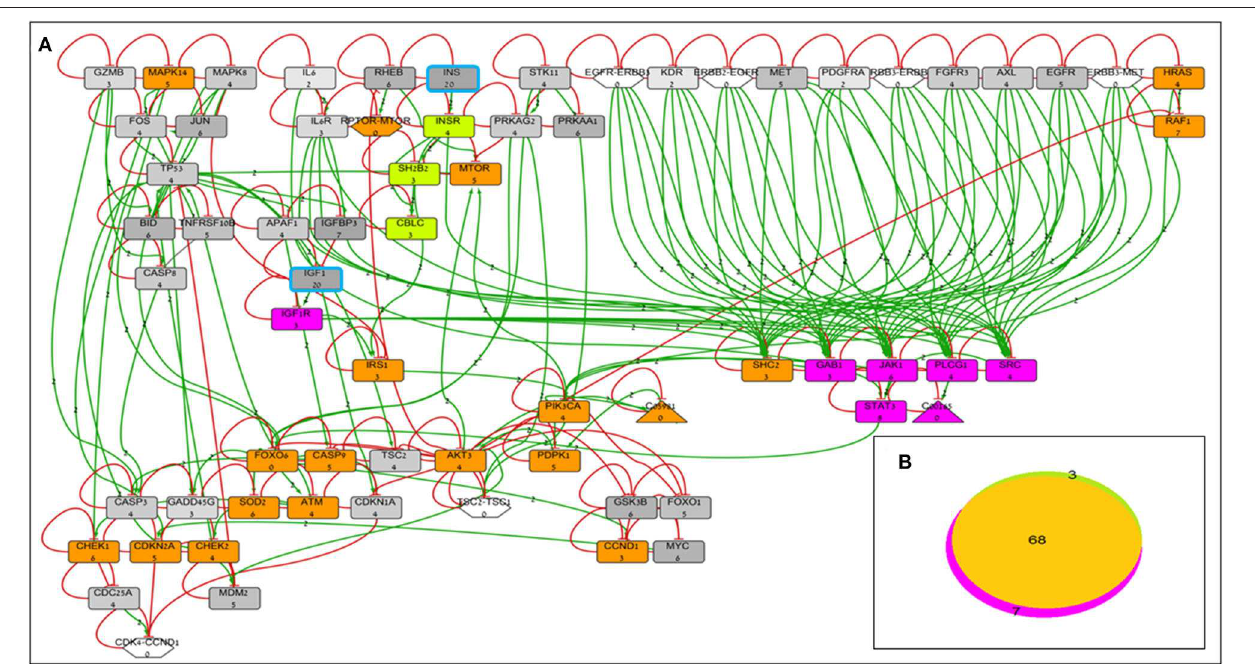
FIGURE 2 | BioNSi network and simulation analyses of MCF7-derived breast cancer cell lines. (A) Reduced network of 68 genes (only biologically tested genes and their neighbors), colored according to their initial expression value (grayscale). The initial expression value is written underneath each gene name. INS and IGF1 expression was manually set as very high ( 20), and genes are highlighted in turquoise frame. Complexes initial expression is zero by BioNSi default. Activation arrow edges are colored green. Inhibition edges are colored red with flat heads. Simulation analyses were performed on the complete network (385 genes). Node’s background was changed after simulations: genes whose expression changed during simulation in both KD cells are colored orange; genes whose expression changed during simulation only in IGF1R-KD cells are colored purple; and genes whose expression changed during simulation only in INSR-KD cells are colored green. (B) Venn diagram of numbers of genes whose expression changed during simulation (specific KD vs. control). Nodes whose expression changed only in IGF1R-KD cells are colored purple (IGF1R, STAT3, GAB1, JAK1, PLCG1, SRC, and diacylglycerol). Genes whose expression changed during simulation only in INSR-KD are colored green (INSR, SH2B2, and CBLC). Overlapping genes whose expression changed during simulation in both KD cells are colored